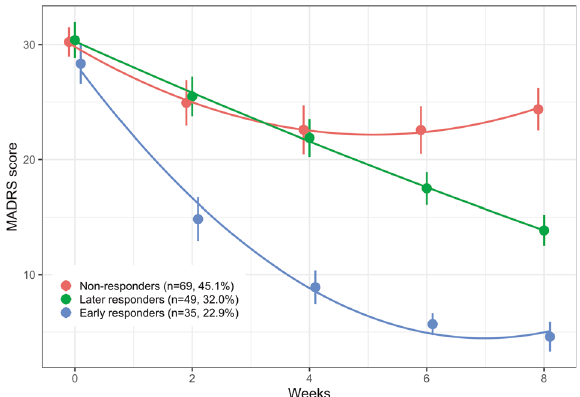
Fig. 1 Trajectories of changes over time in MADRS score. Observed mean of the Montgomery-Åsberg Depression Rating Scale (MADRS) score according to treatment status determined at T8. Responders are those showing a 50% reduction in MADRS score at T8, of which we distinguished early responders (50% reduction in MADRS score criterion already met at T2), and later responders (50% reduction in MADRS score criterion met after T2).